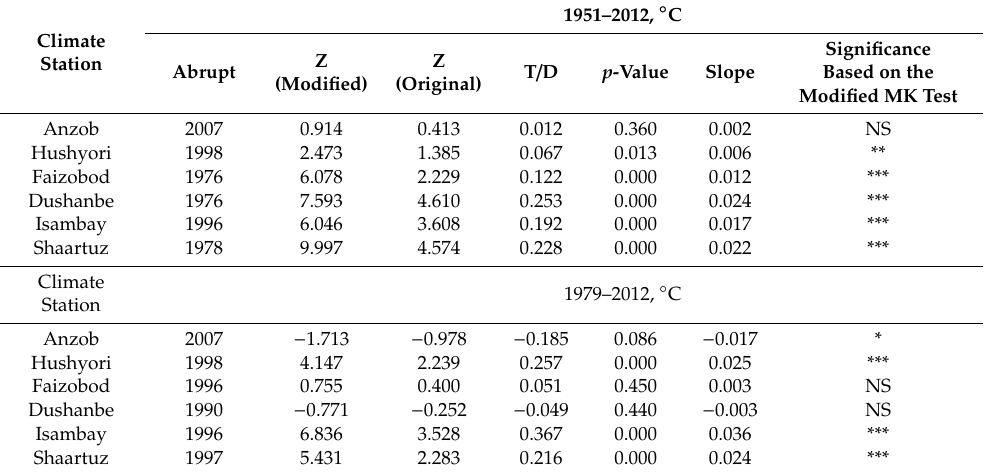
Table 4. Annual temperature trends per decade (T / D), Sen’s slope, abrupt-point analysis, and original and modified Mann–Kendall (MK) tests for the trends (Z) in the Kofarnihon River Basin, Central